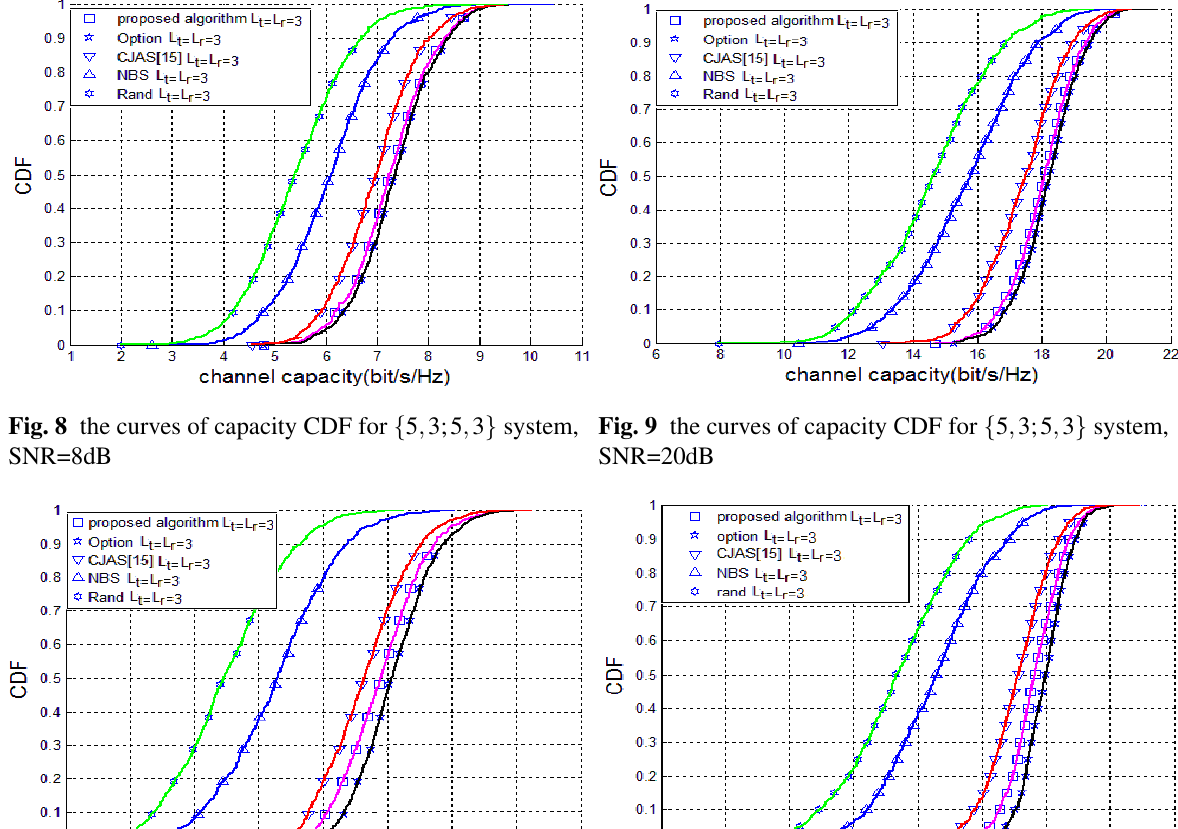
Fig. 11 the curves of capacity CDF for { 7 , 3;7 , 3 } system,